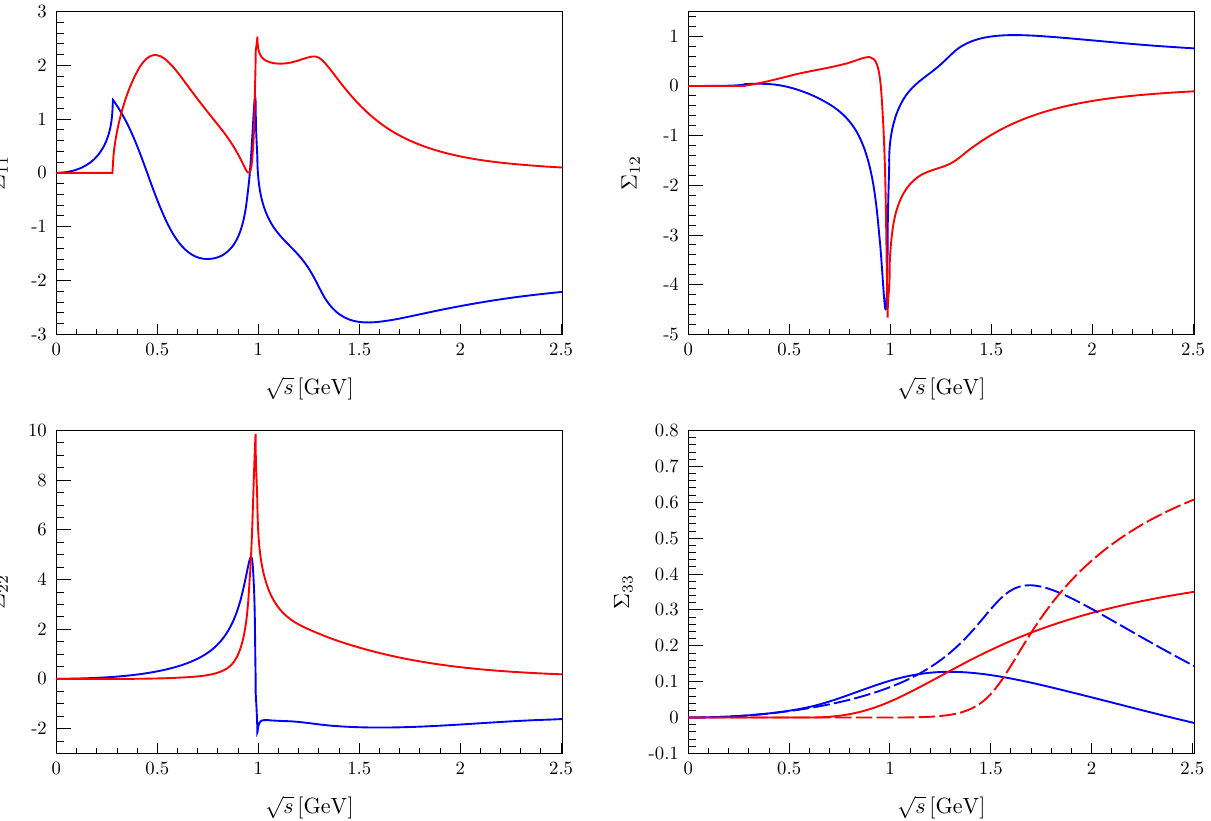
Fig. 2 Real (blue) and imaginary (red) parts of the self-energy functions Σ 11 , Σ 12 = Σ 21 , Σ 22 , and Σ 33 , using the Omnès matrix displayed in Fig. 1. Note that Σ 33 is a once-subtracted dispersion integral over the four-particle phase space factor taken as a σσ (solid) or a ρρ (dashed)